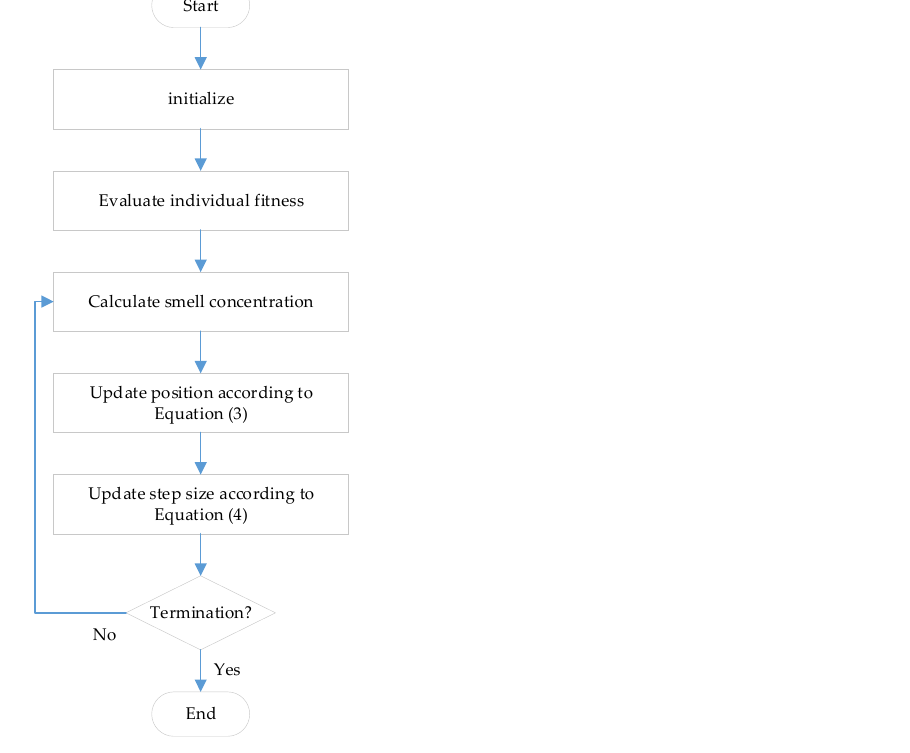
Figure 2. BAS algorithm flow chart.